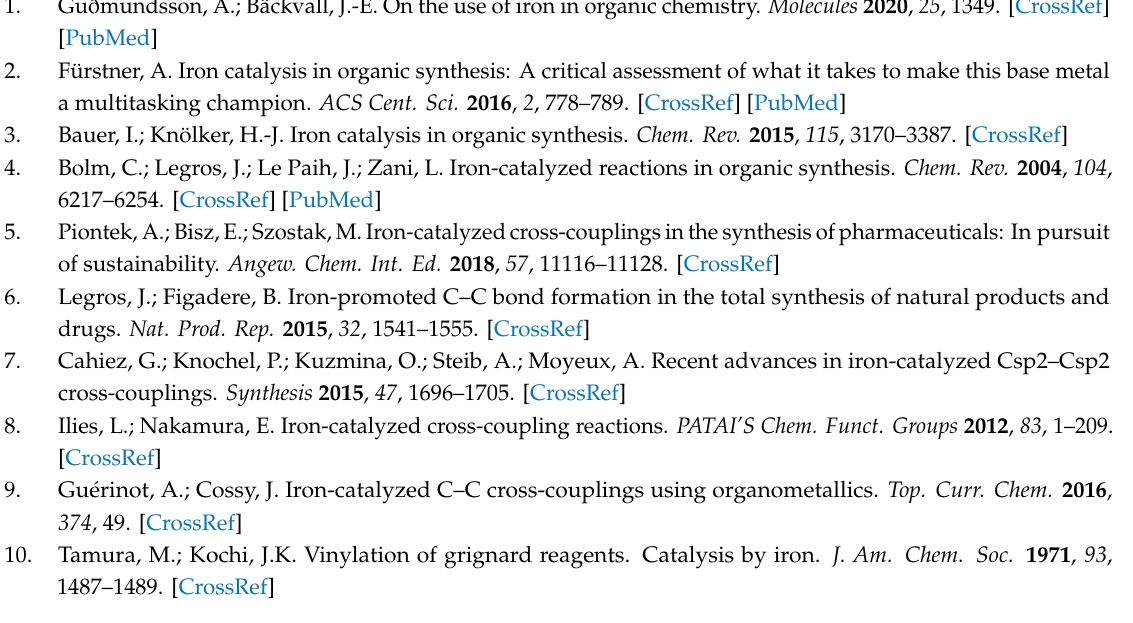
the reaction of Fe II / Fe III mechanism, Figure S3: Energy profile for Fe I / Fe II / Fe III pathway starting the reaction from iron(I) species, Figure S4: Comparison of geometrical parameters of X-ray crystal structure of 2 PhBr and 2 BrBr with the optimized geometry in quintet spin state, Table S1: The comparison of energies for the iron(I), iron(II) and iron(III) complexes in di ff erent spin states at B3LYP-D3 and OPBE-D3 functionals. Table S2: Comparison of free energy barriers of catalytic cycle at B3LYP-D3 and CAM-B3LYP-D3